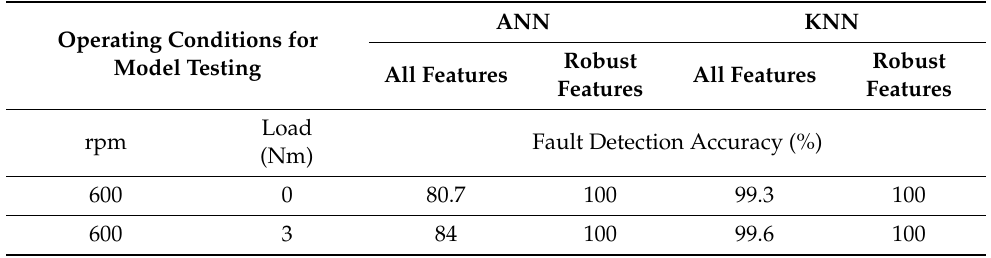
Table 3. Performance of AI models trained at intermediate speed and load (1800 rpm and 3 Nm